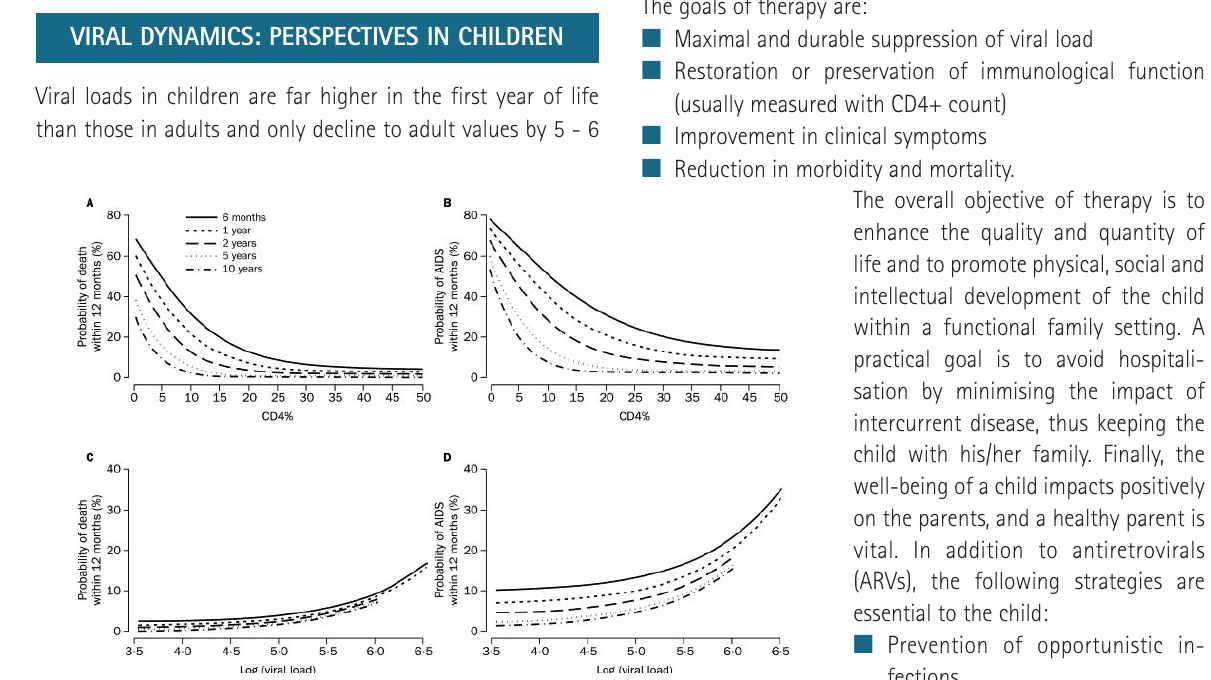
Fig. 1. CD4% v. probability of death (A) and AIDS (B) in 12 months, and viral load v. probability of death (C) and AIDS (D) in 12 months (source – Lancet 2003; 362 1605-1611)